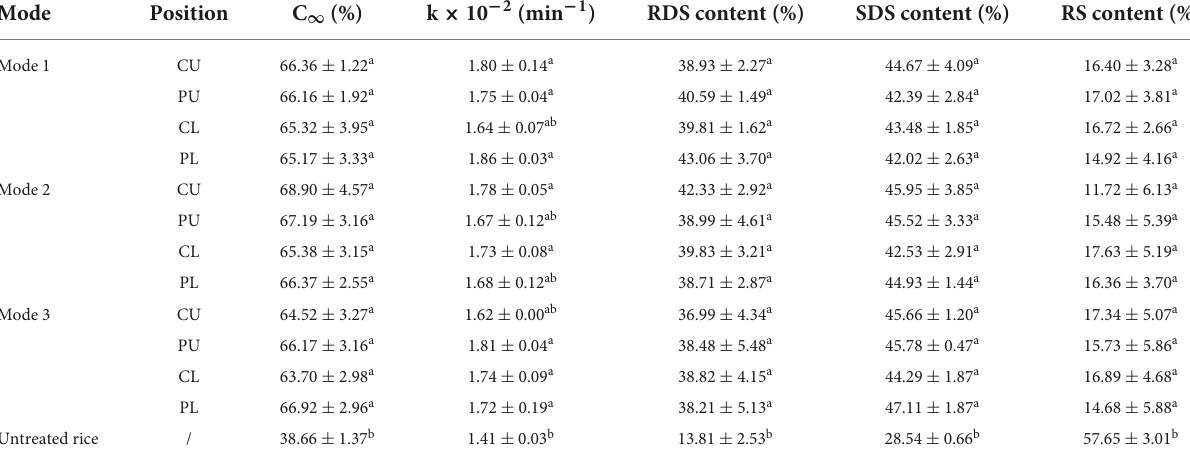
TABLE 3 Starch digestion characteristic parameters of raw rice and rice cooked under different heating